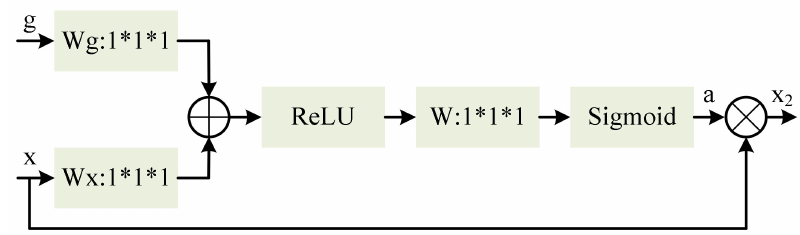
Figure 5. The structure of the attention module.